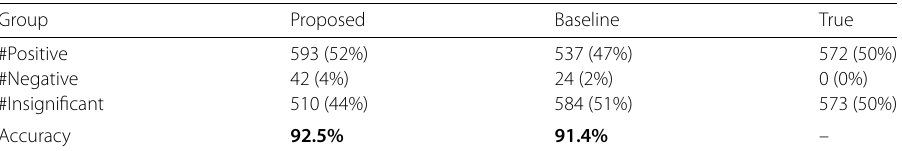
Table 3 Accuracy of detecting susceptible users when the topic trend is not a confounding factor ( c = 0). “Proposed” and “Baseline” represent the introduced model with or without the topic trend g ( k , t ), respectively